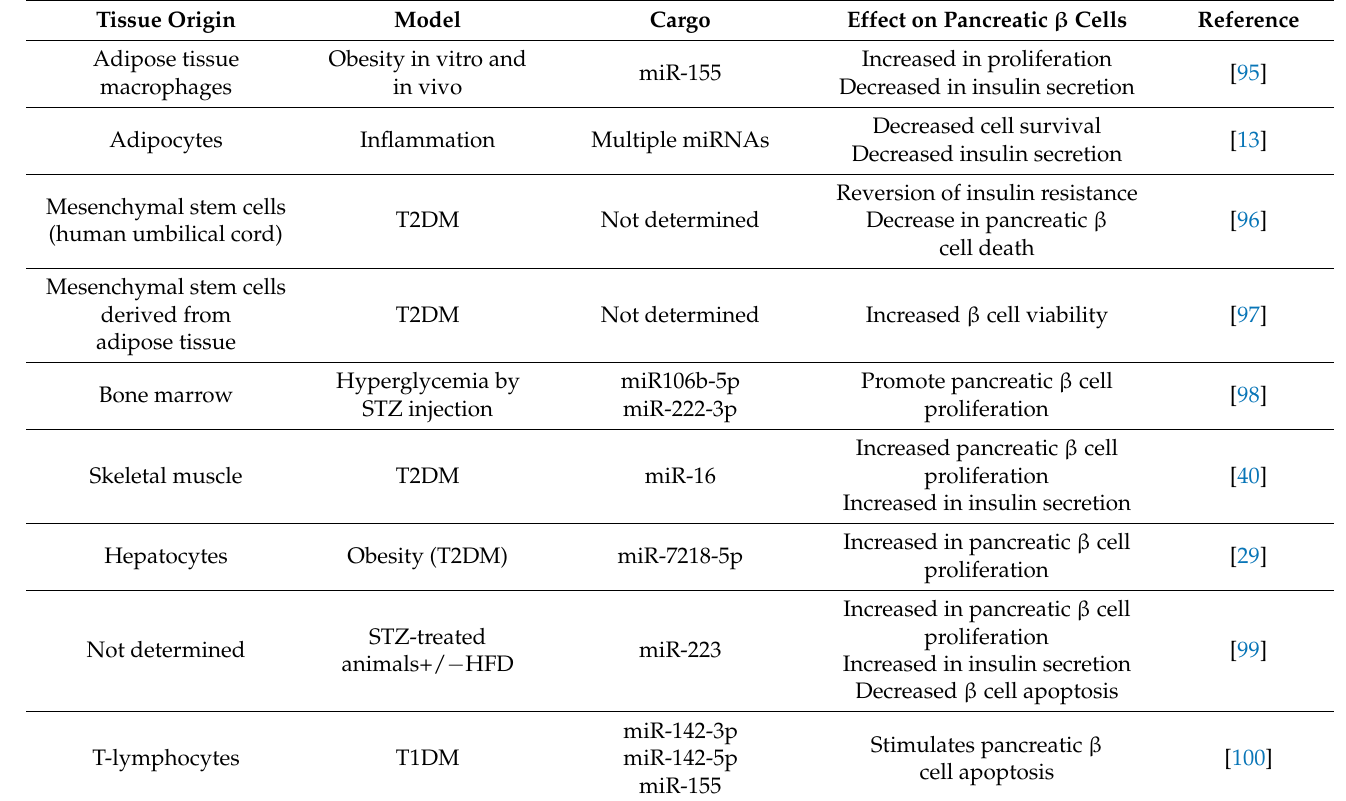
Table 1. Bioactive cargoes in EVs from diverse tissues and organs that can influence pancreatic beta-cell functionality and/or